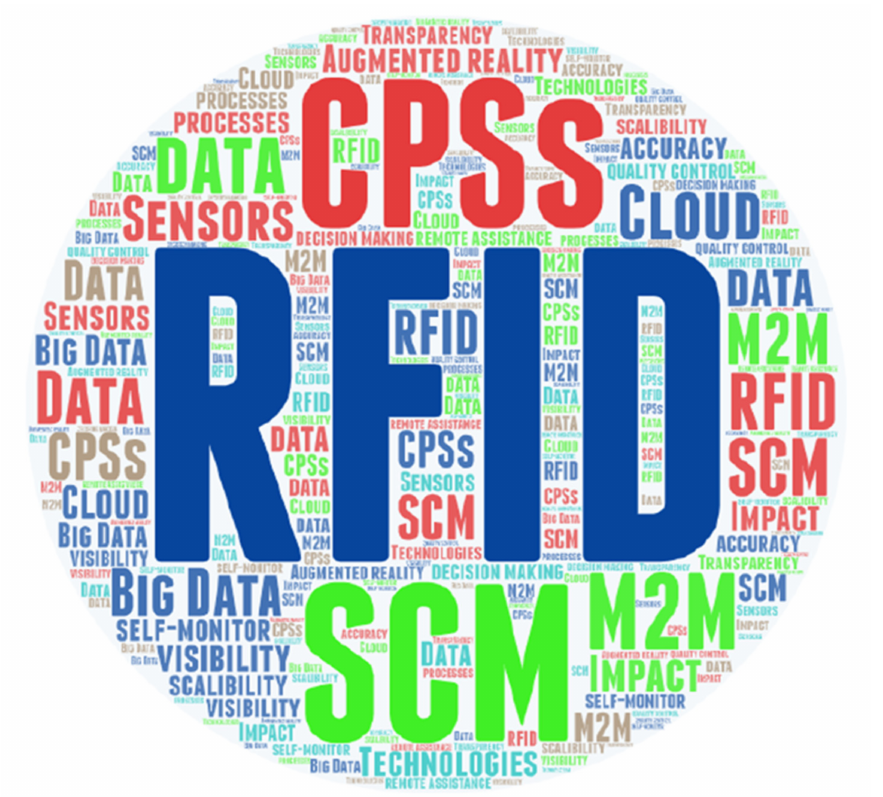
Figure 8. Word cloud showing key recurring themes of IoT technologies within the